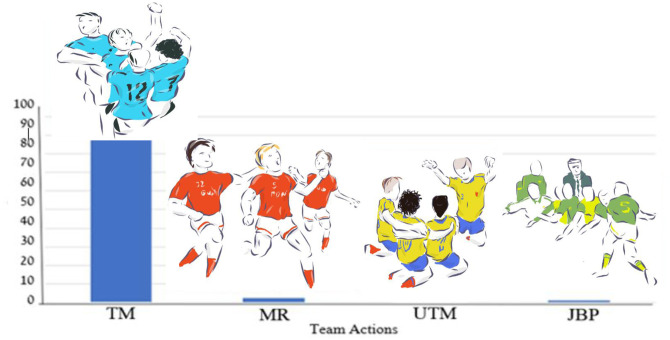
Percent of team players’ celebration actions (k = 4; # of actions = 345) in 366 goal celebrations.Index: TM–Team movements; UTM–Unified team movements; MR–Players run toward audience; JBP–Join bench players.